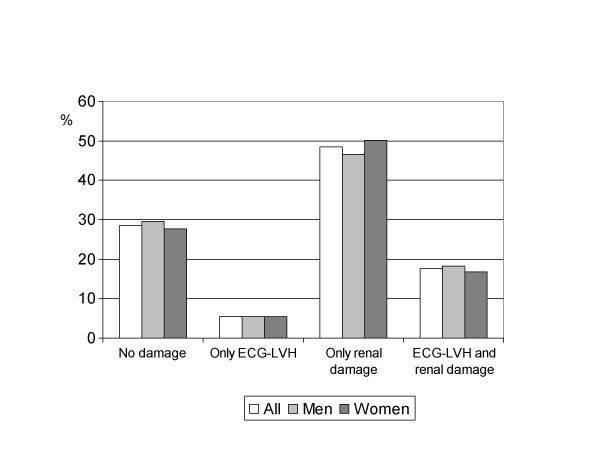
Distribution of the study population according to cardiac and/or renal damage. ECG-LVH: electrocardiographic left ventricular hypertrophy